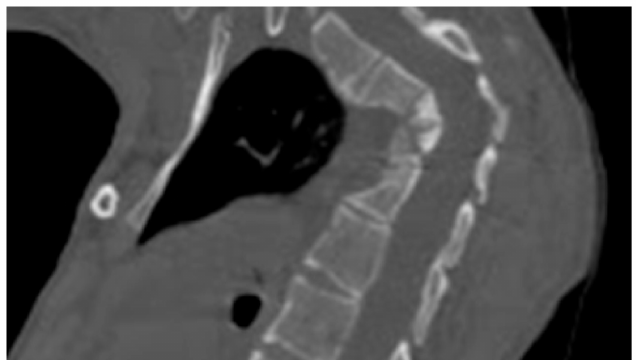
Figure 2. 3D reformatted CT scan in a 10-years-old-girl showed progressive osteolysis of T3-T6. Resulted in the development of progressive acute kyphosis of 90 ◦ Cobbs angle. Skeletal survey did not show any other involved